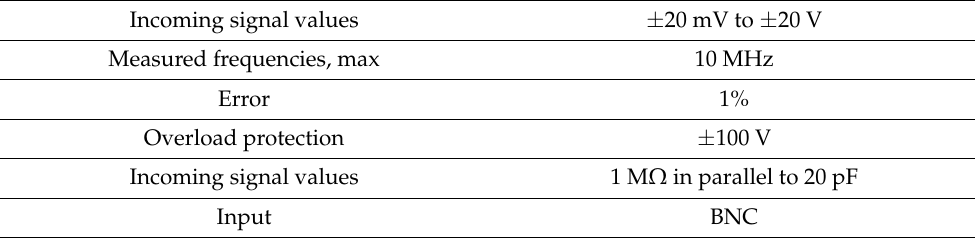
Table 8. Sensor characteristics. Reprinted from ref. [61].